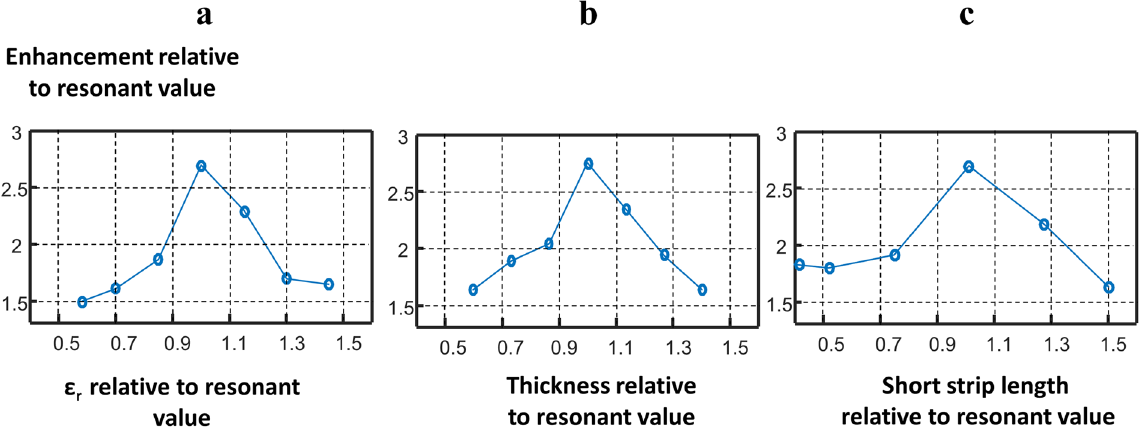
Figure 5. Parametric-dependence plots of the maximum enhancement ratio (averaged over a ROI of 6 × 6 mm) versus the value at resonance: ( a ) relative permittivity of the dielectric substrate, ( b ) thickness of the dielectric substrate and ( c ) length of the shorter